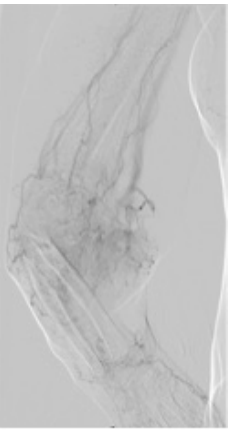
Figure 2: Arteriography of the right arm that revealed a 7 cm mass on the arteriovenous